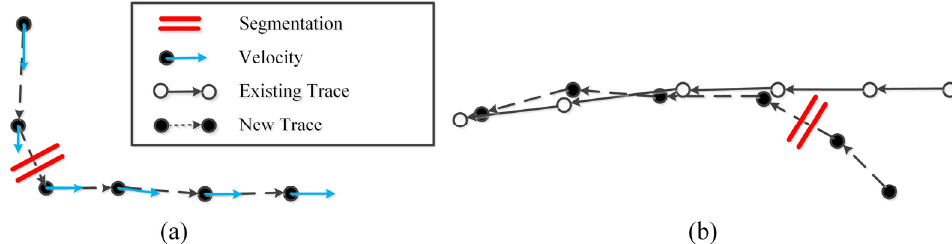
Figure 2. Segmentation of new trace by ( a ) heading and ( b ) similarity to existing map.